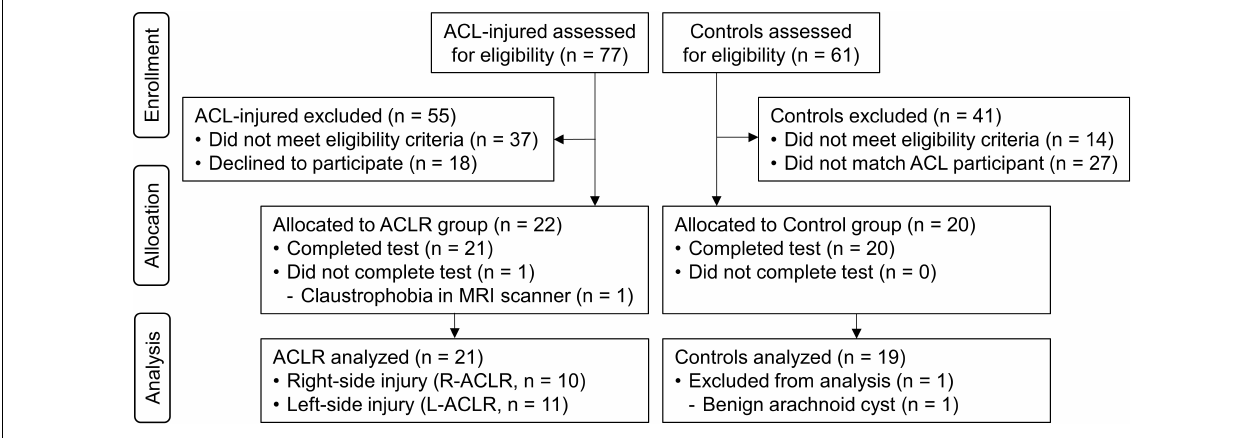
FIGURE 2 | Flow diagram illustrating the recruitment